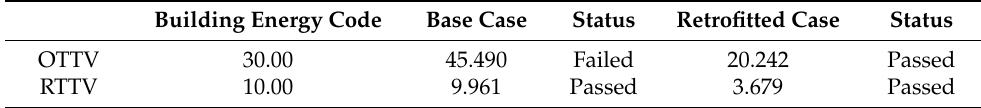
Table 13. Thermal transfer values (W/m 2 ) in comparison with building energy code.